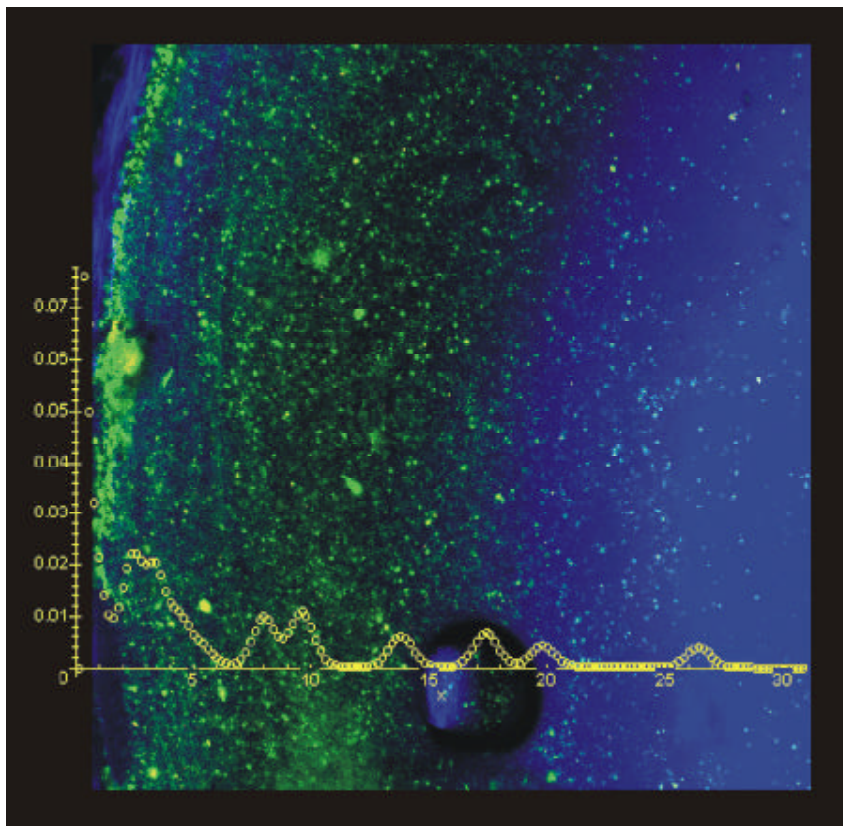
FIGURE 4. Biofilm: distribution of cells into alginate